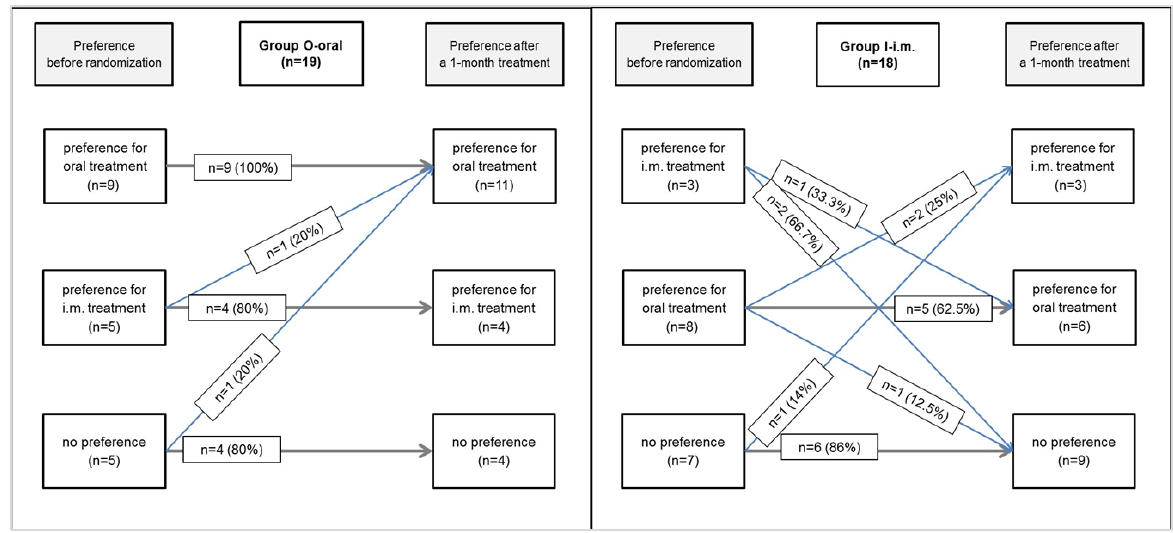
Figure S1: Patients preferences before and after 28 days of treatment administered by the oral (n = 19) or IM route (n =